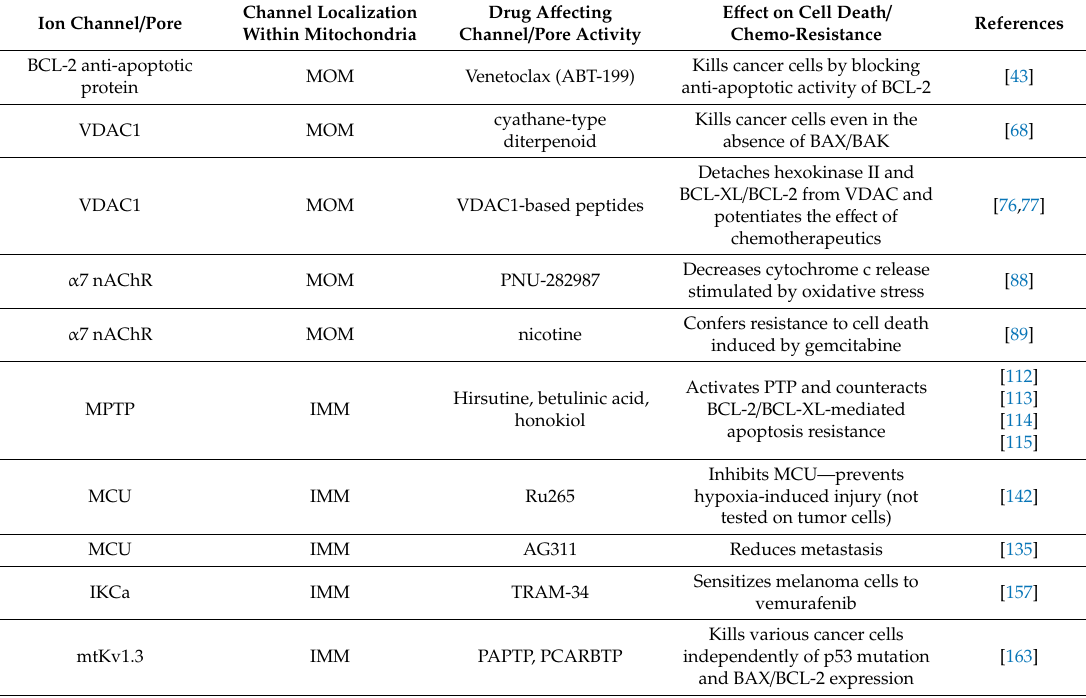
Table 1. List of ion channels as drug targets against chemo-resistance. The direct e ff ect of AG311 on MCU has not been proven